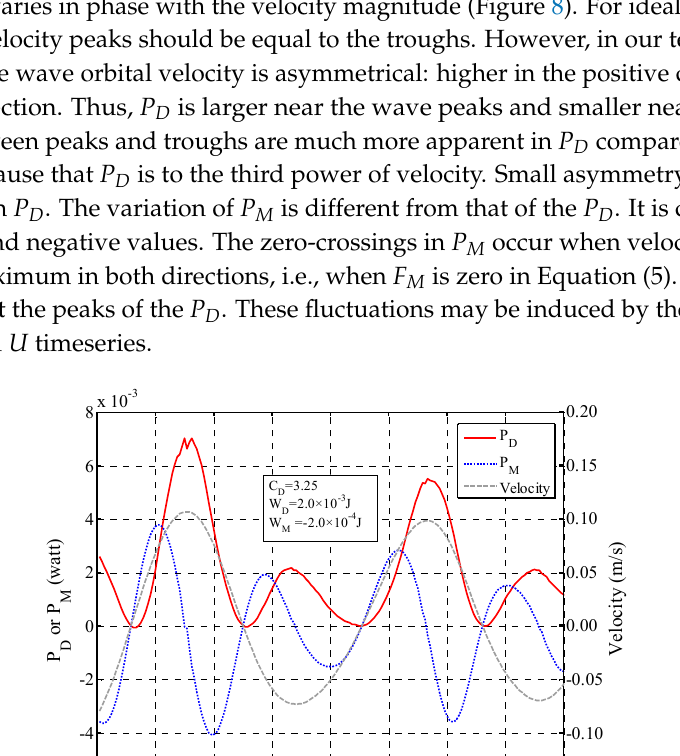
Figure 8. Time-varying U , P D , and P M over two wave periods. The shown test case is wave0712, with 7 cm wave height and 1.2 s wave period. The averaged work done by drag force ( W D ) and inertia force ( W M ) over the shown two periods is 2.0 × 10 − 3 J and − 2.0 × 10 − 4 J , respectively. The derived period-averaged C D is 3.25.